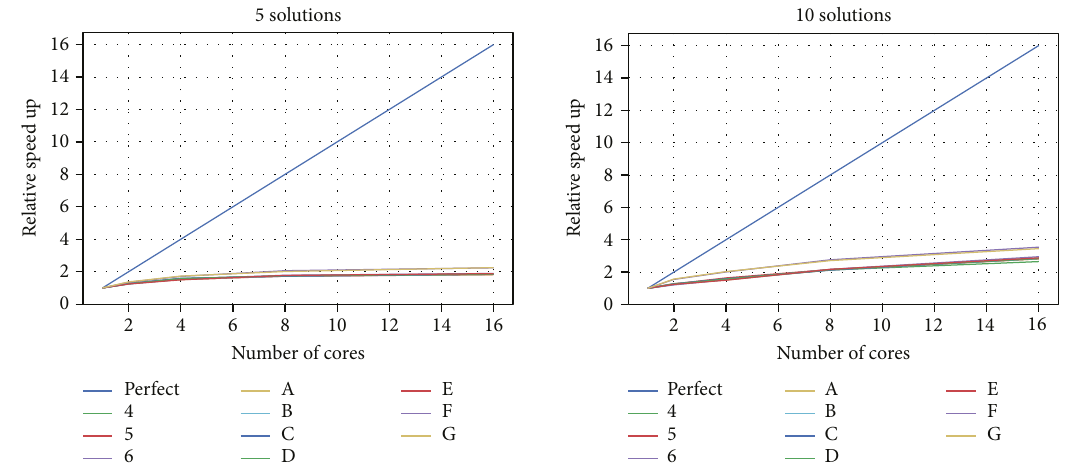
Figure 7: Speed up charts for 5 and 10 solutions.